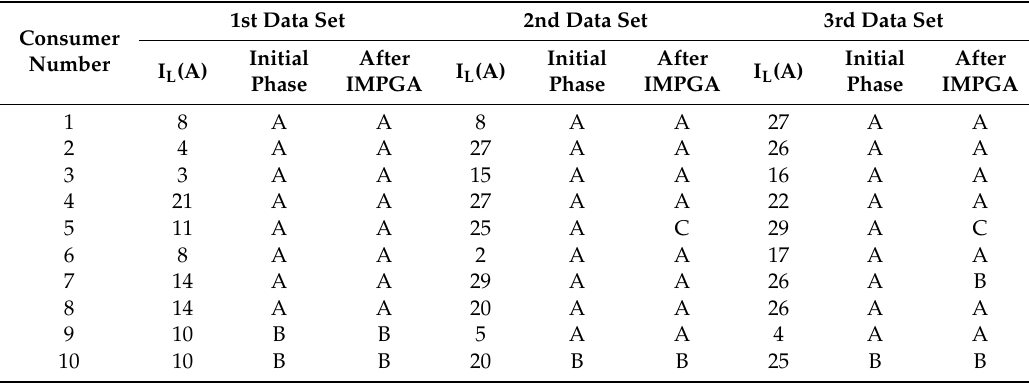
Table 3. Comparison of e ff ects before and after three-phase unbalanced